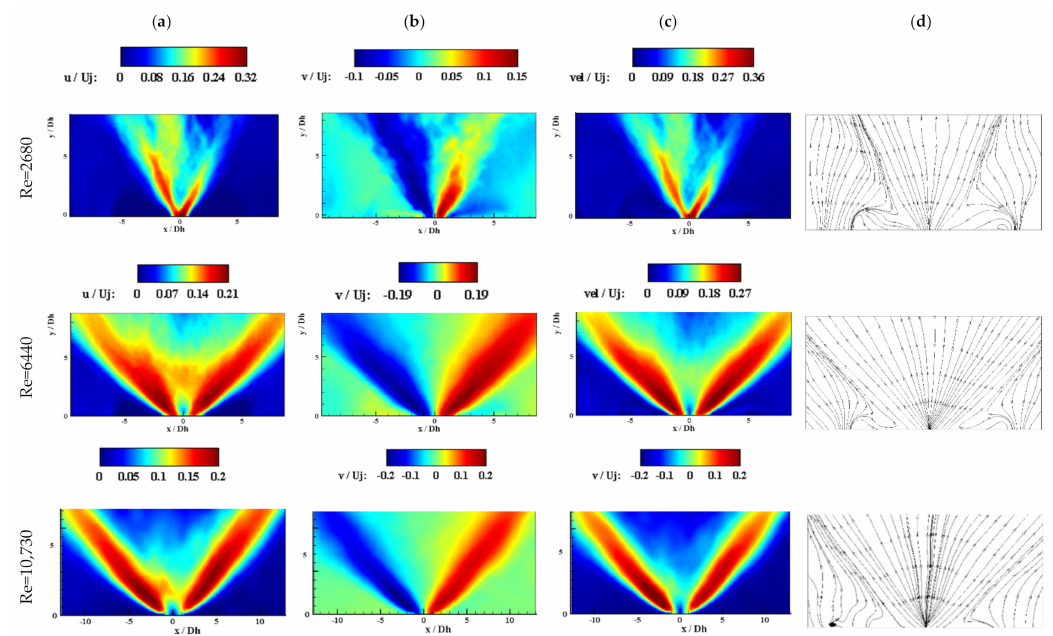
Figure 6. Time average of ( a ) streamwise velocity, ( b ) transverse velocity, ( c ) velocity magnitude, and ( d ) streamline for free external domain at Re = 2680, 6440, and 10,730 and z / D h =